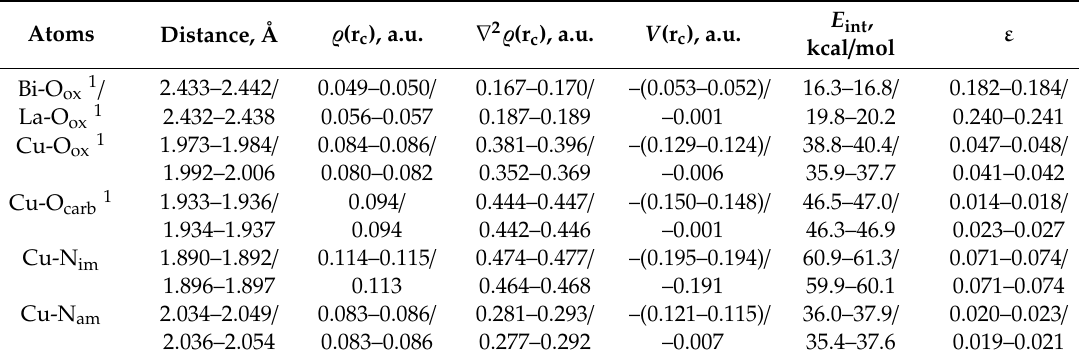
Table 3. Optimized interatomic distances, topological, and energy parameters at the (3,–1) critical points of the coordination bonds in the [Bi(15-MC Cu(II)Tyrha -5)] 3 + / [La(15-MC Cu(II)Tyrha -5)] 3 + complexes. Table 2.